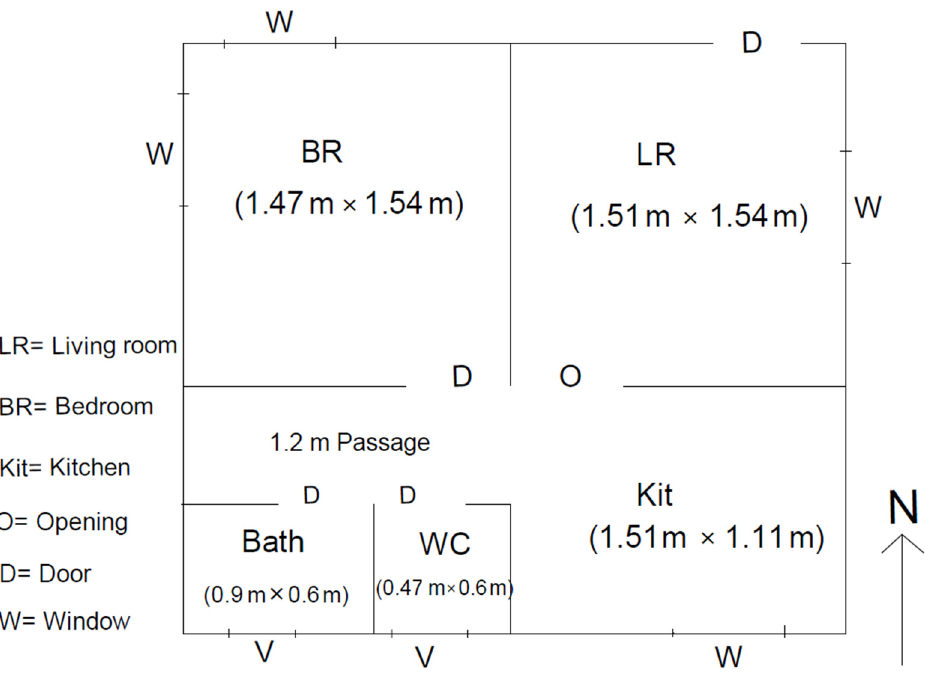
Figure 5. Plan of the proposed model house.